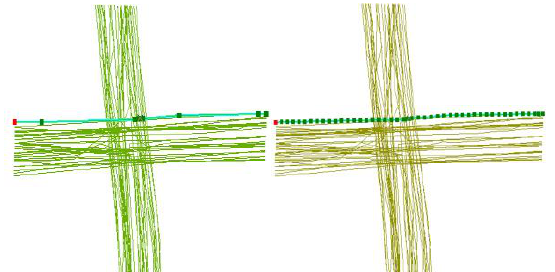
Figure 2. Transport land-use extraction using Delaunay